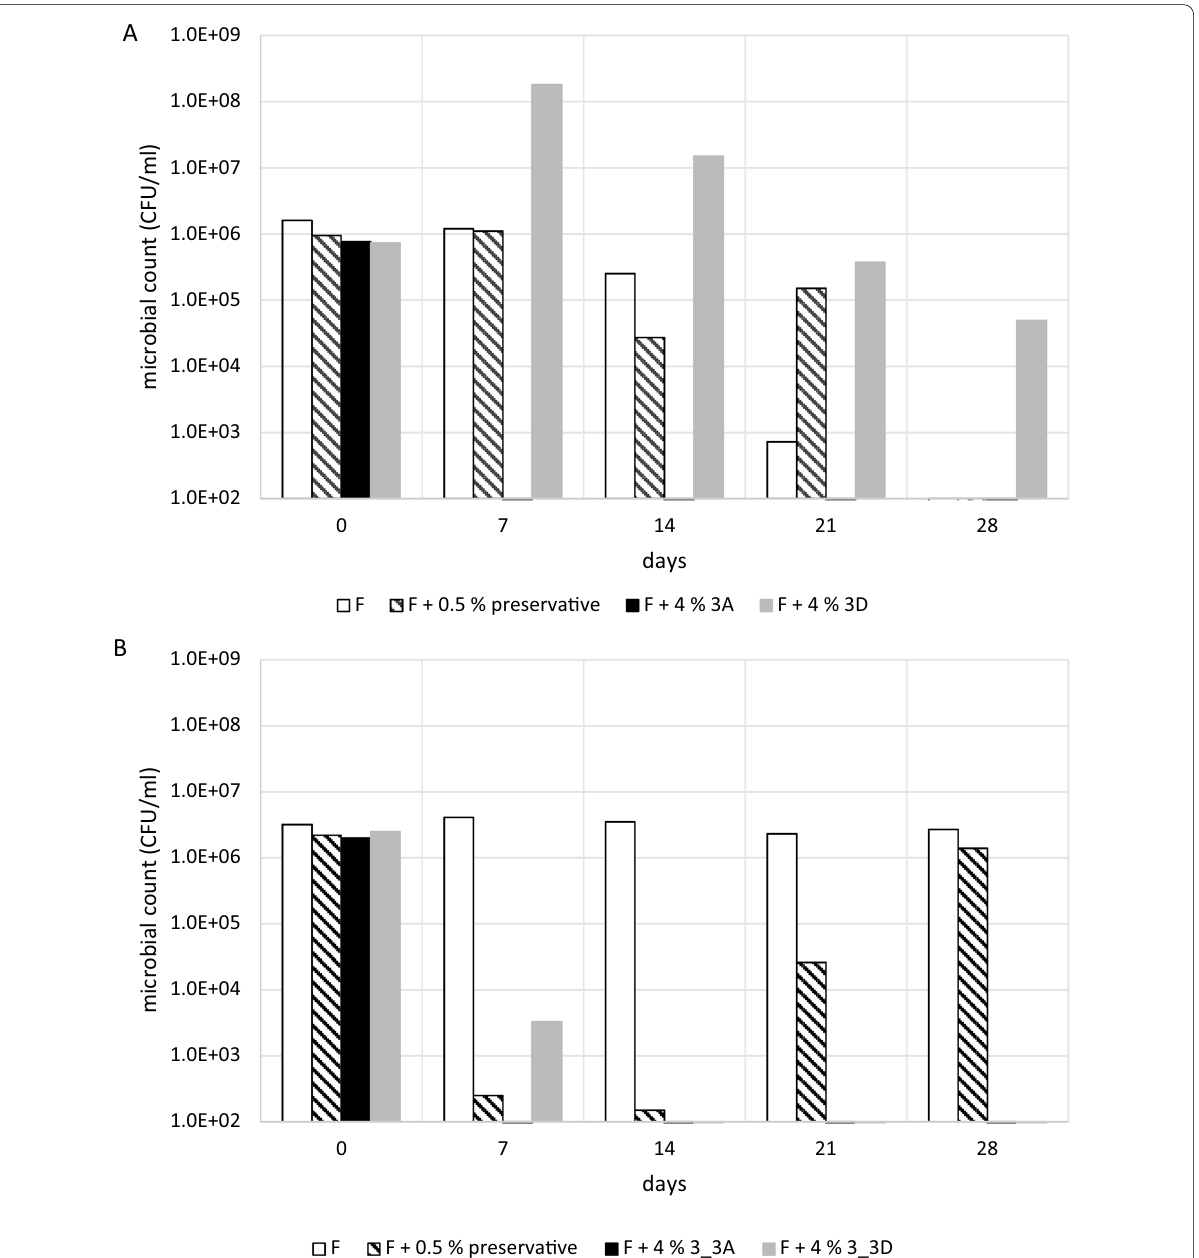
Fig. 3 Microbial challenge test in a standard cosmetic cream formula. Samples were taken weekly for 4 weeks and incubated for 72 h with A S. aureus or B P. aeruginosa before serial dilution and colony counting. F control. F 4% 3A enzyme‑treated chicory extract. F + =